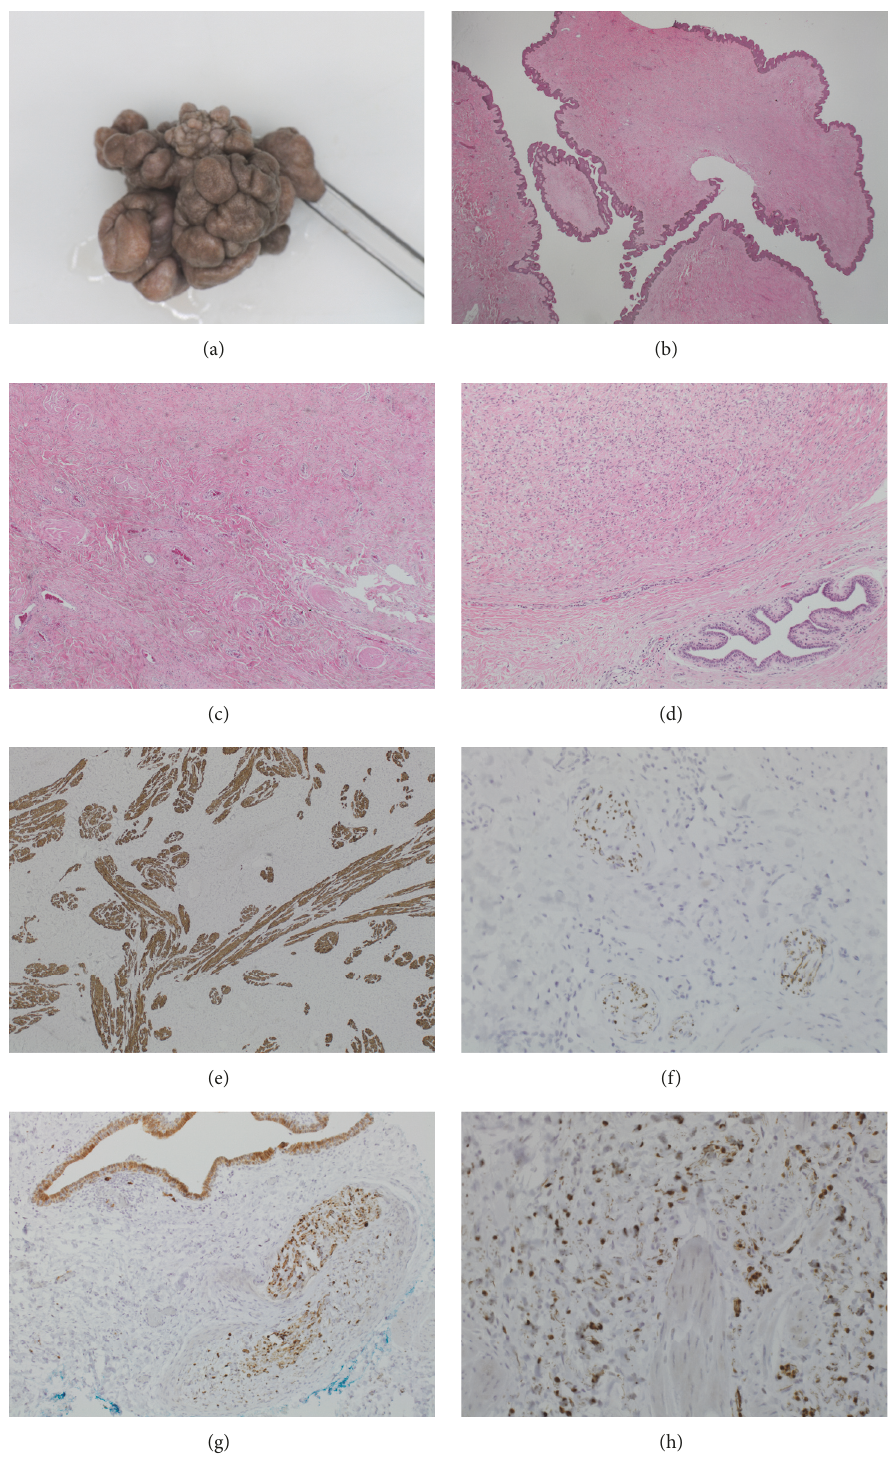
Figure 1: Macroscopic and microscopic appearances of the nipple neurofibroma . (a) Gross appearance of the largest lesion showing a pedunculated polypoid mass. (b) Overall H&E view showing a polypoid lesion covered by unremarkable squamous epithelium. (c) Low power H&E section showing bland spindle shaped cells interspersedwith smooth muscle bundles of the nipple. (d) High power H&E section showing moderately cellular bland spindle cells extending close to a large mammary duct. There is no cytological atypia or mitoses. The adjacent mammary duct is benign and lined by inner luminal and outer myoepithelial cells. The lesional spindle cells show immunoreactivity for desmin (e), neurofilament (f), and S100 (g and